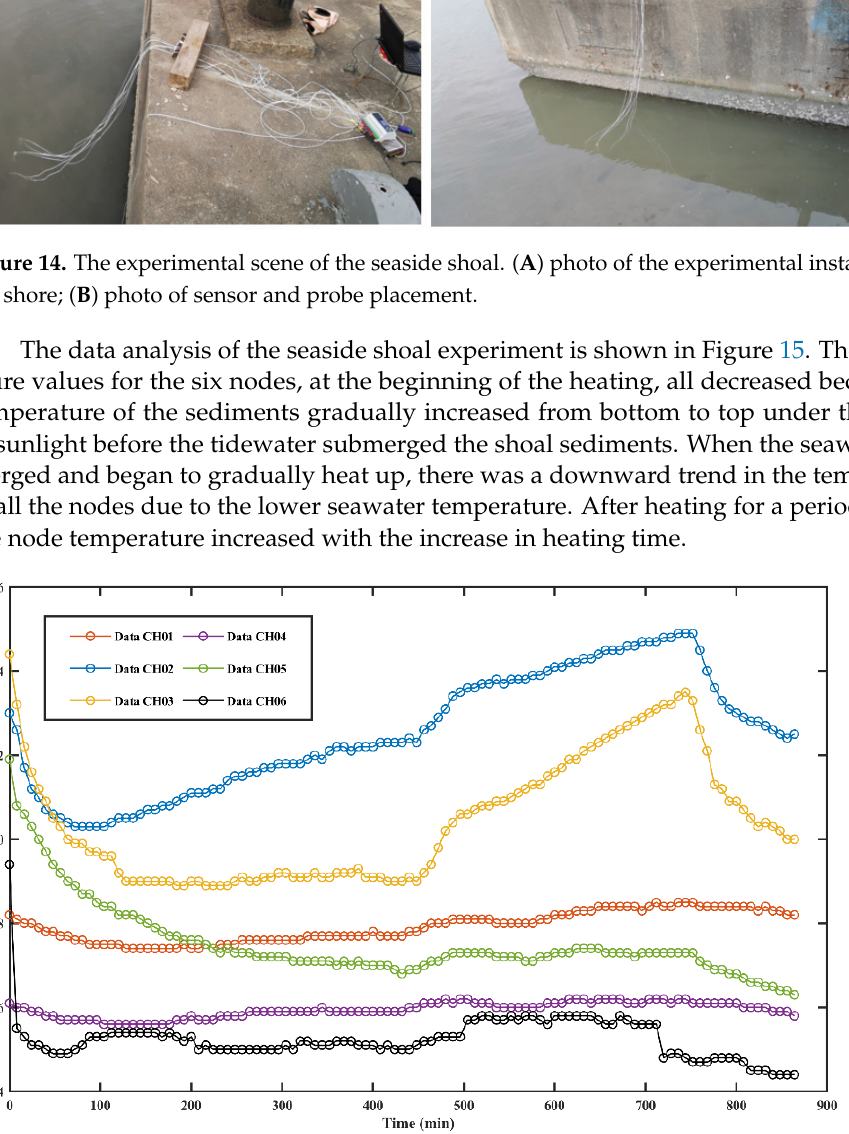
Figure 13. Arrangement of heating source and temperature sensors in the seaside shoal. 1#–7# in the figure represent temperature sensors 1–7.